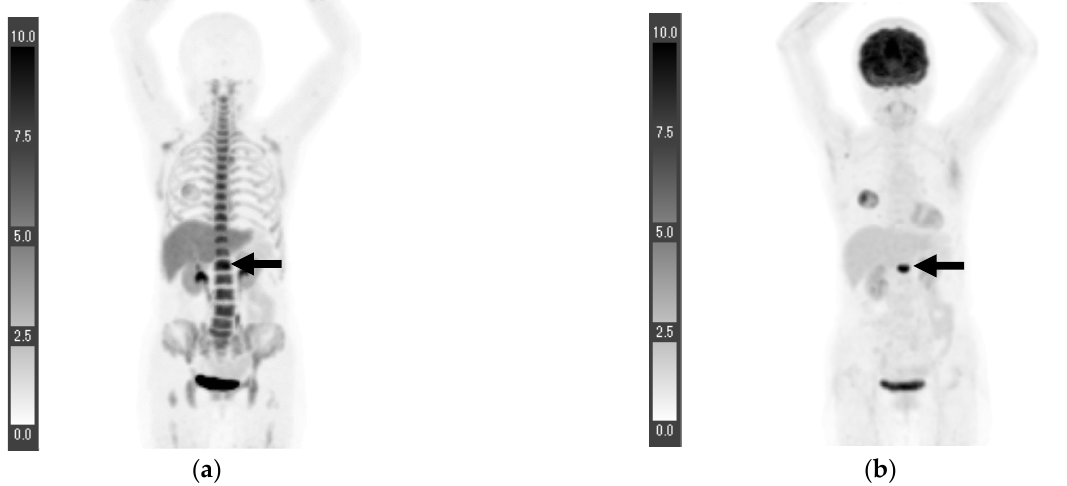
Figure 3. Maximum intensity projection (MIP) of 18 F-FLT PET ( a ) and MIP of 18 F-FDG PET 25 days before the 18 F-FLT PET/CT ( b ). The patient had a first lumbar vertebra metastasis, and the SUVmax of the 18 F-FLT PET/CT and 18 F-FDG PET/CT were 10.8 and 12.6, respectively (arrows). Patient 6 (Figure 3).